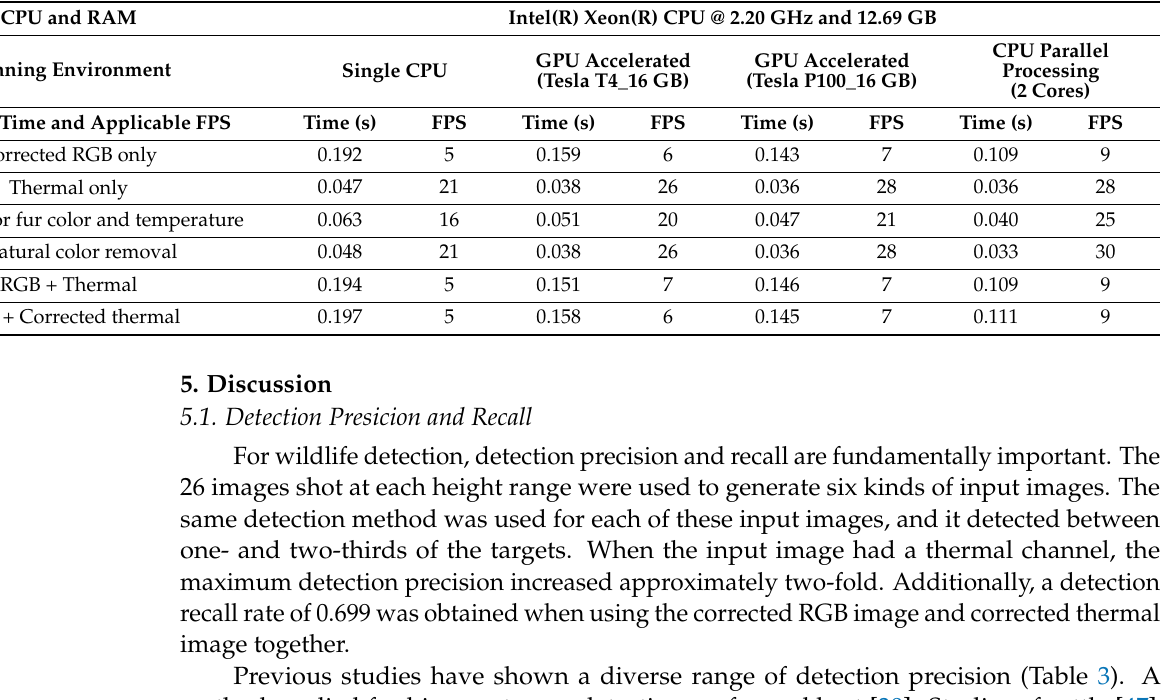
Table 2. Time needed for detection by type of image under four kinds of processing environment. CPU and RAM Intel(R) Xeon(R) CPU @ 2.20 GHz and 12.69 GB Running